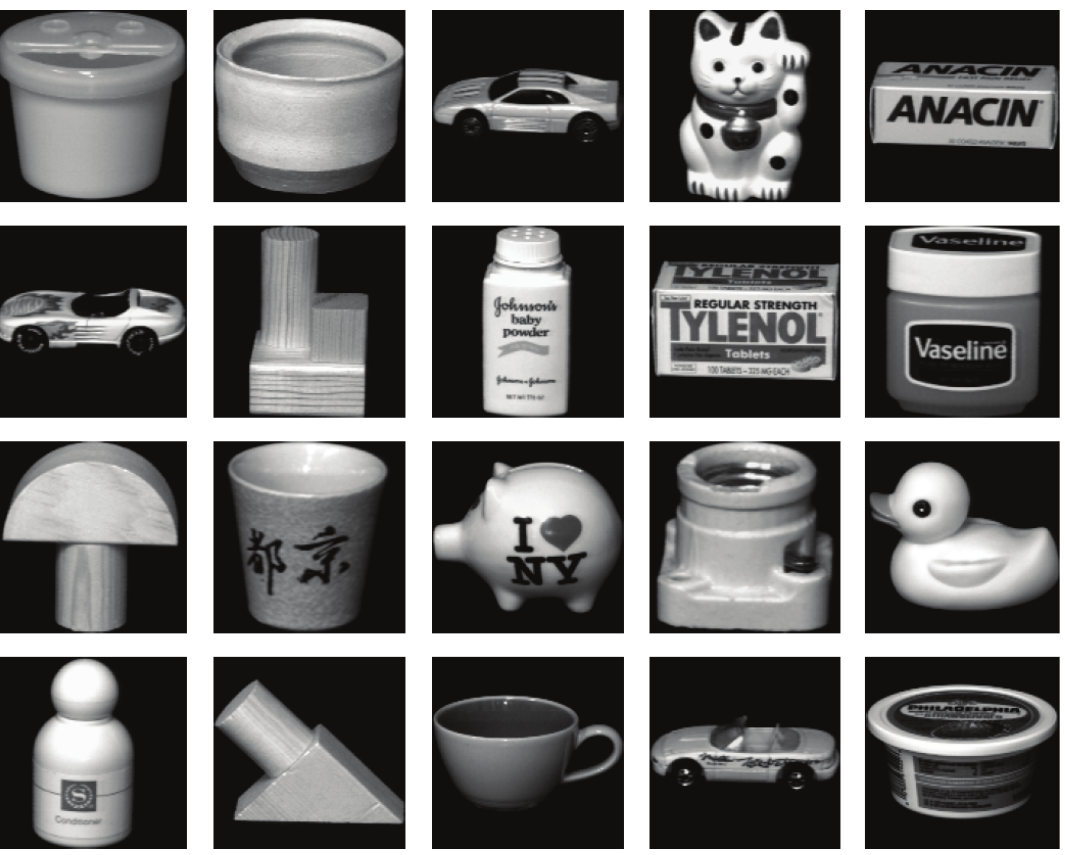
Figure 6: Columbia Coil-20 image database. Table 2: Classification accuracies of AMIs, MSA, and the proposed method for images in Figure 6 in case of affine transformation and different intensities of salt and pepper noise.